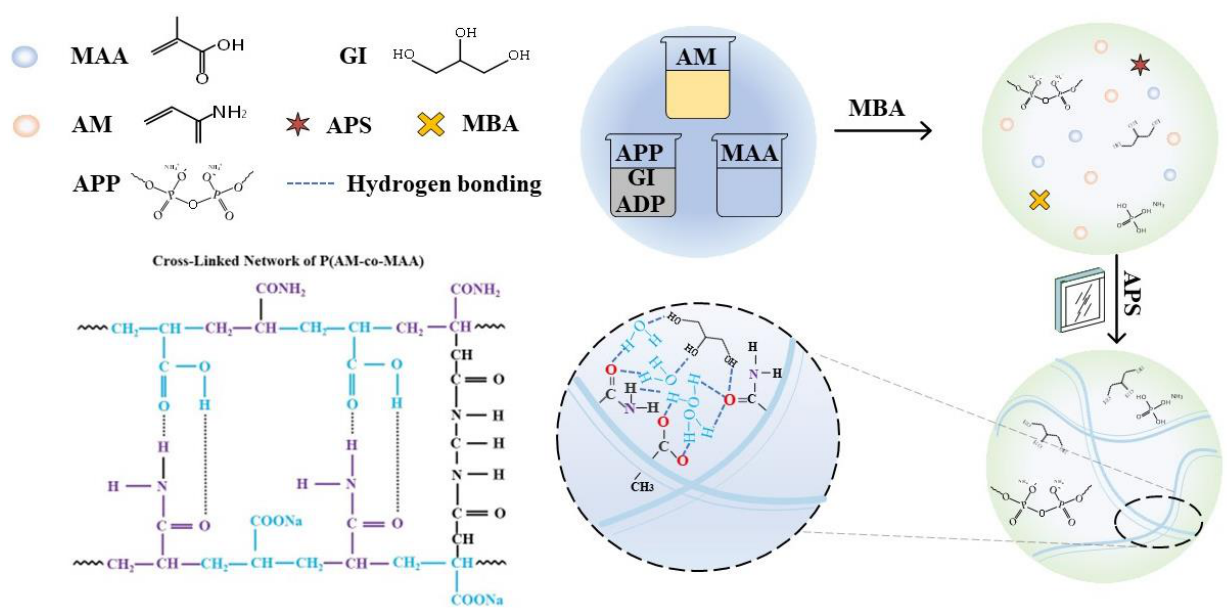
Figure 1. Preparation process of multifunctional transparent flame-retarded hydrogel.